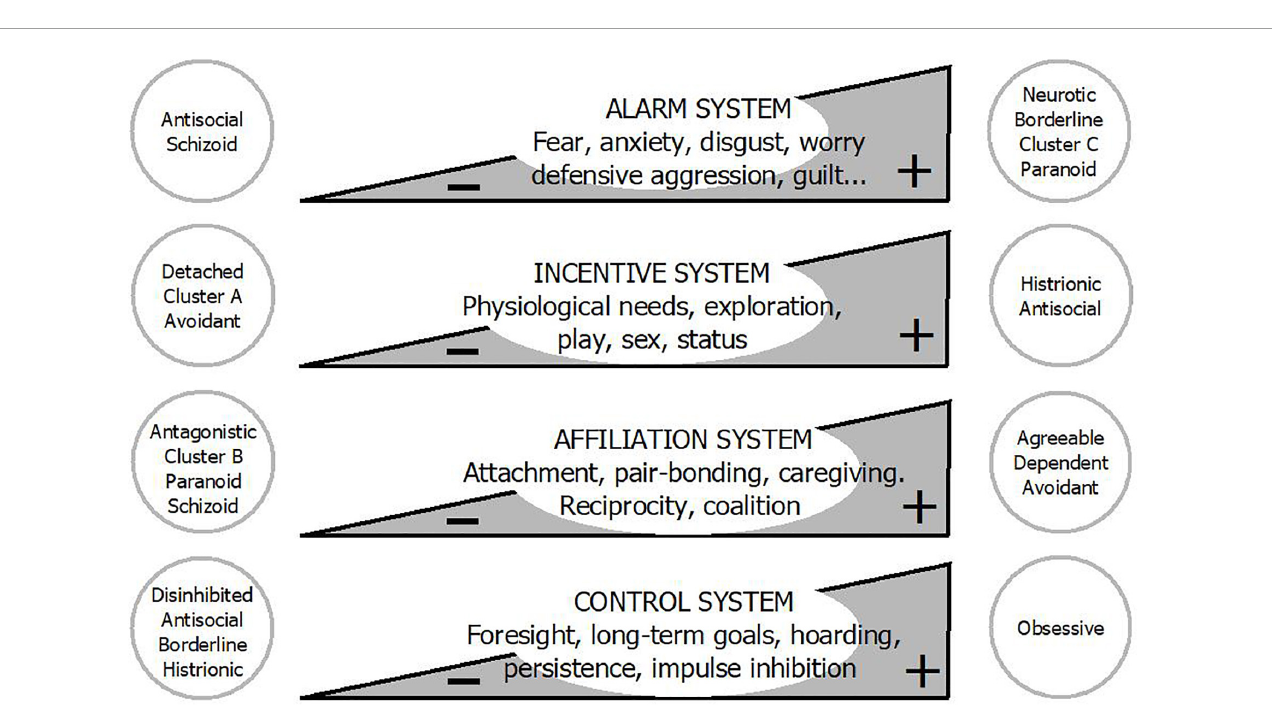
FIGURE2 Personality disorders are not qualitatively different from normal personality: They are located at the extremes of basic action systems. Adapted from Gutiérrez (38) with permission from Siglantana